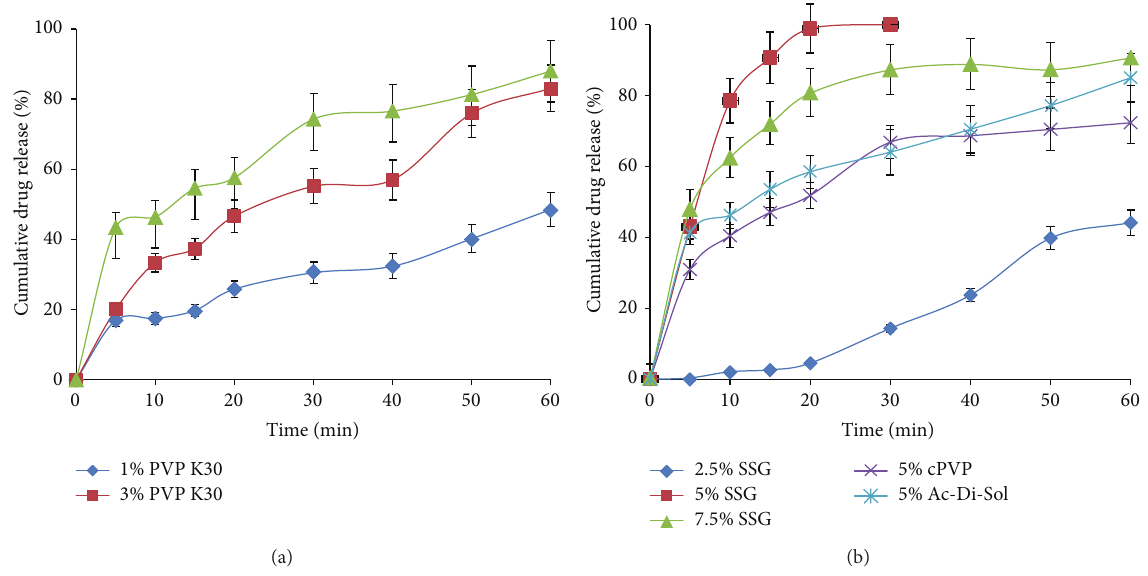
Figure 1: Dissolution profiles showing (a) the effect of binder concentration and (b) effect of superdisintegrants on drug release.